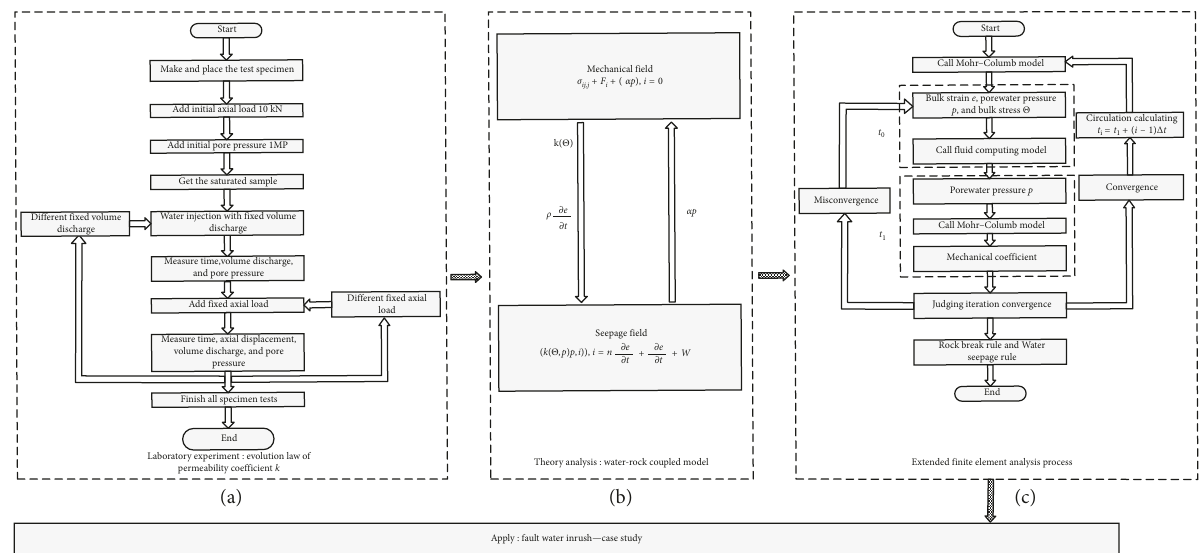
Figure 2: The research process of the